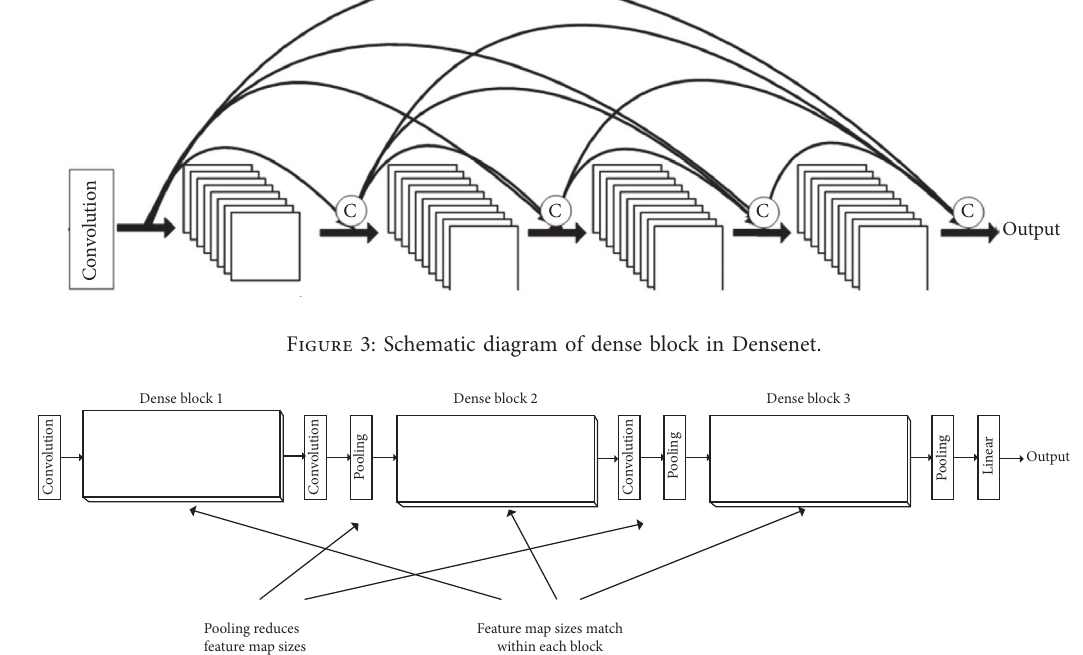
Figure 4: Schematic diagram of Densenet